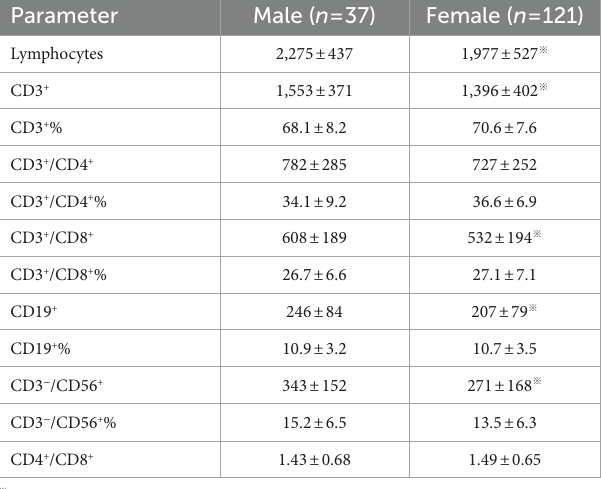
TABLE 3 Absolute values and percentages of lymphocyte subpopulations in experimental group by sex (Mean ± SD, cells/ μ L).